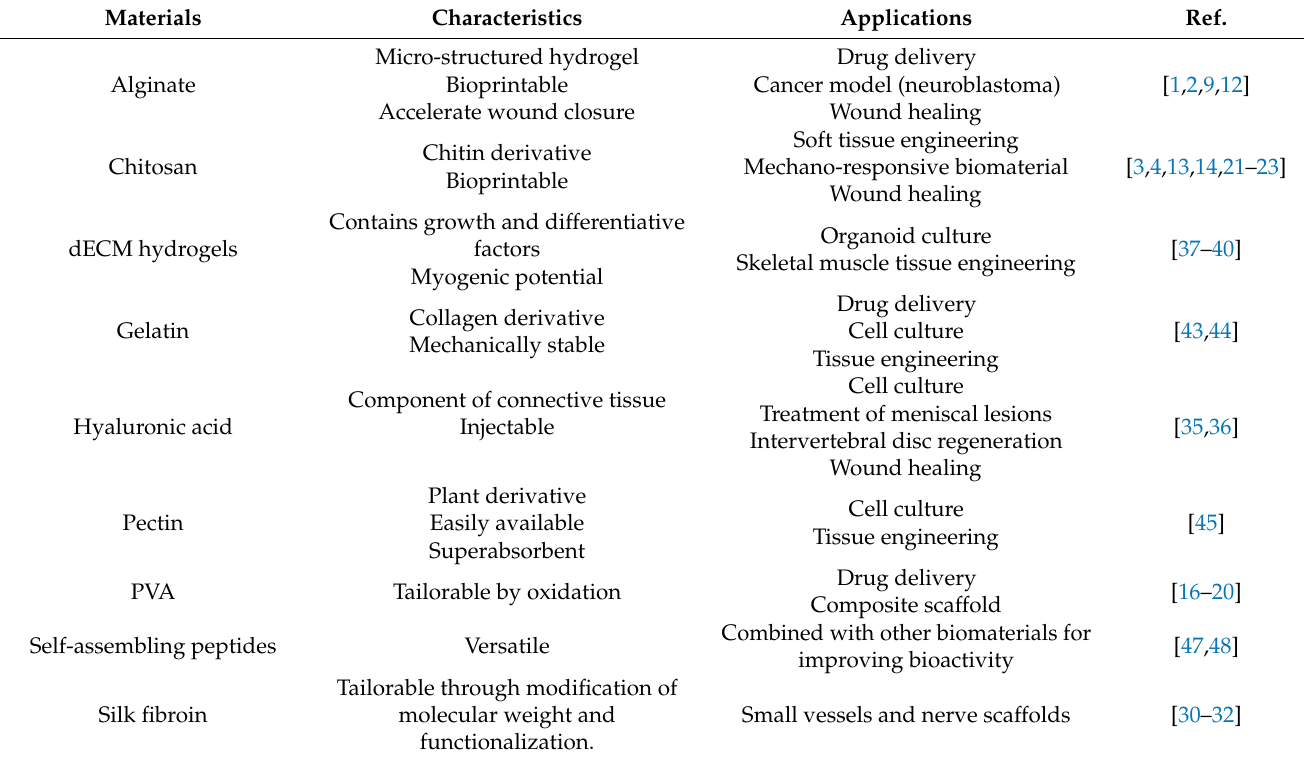
Table 1. Characteristics and applications of